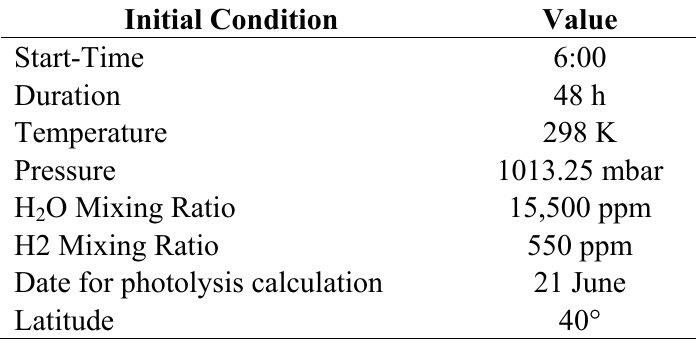
Table 1. Conditions used for all simulations.